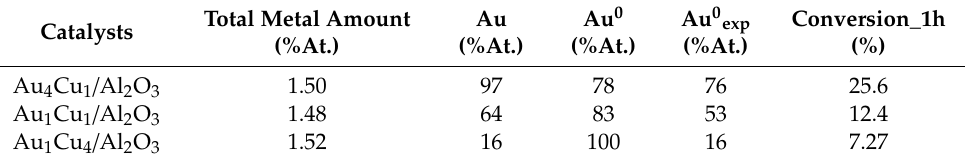
Table 3. Amount of exposed metal and gold exposure of Al 2 O 3 -supported catalysts.